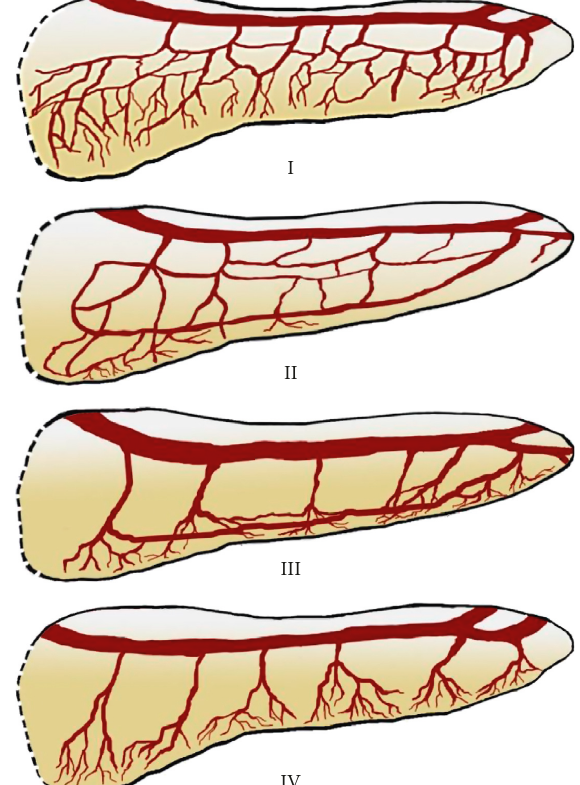
Figure 2: Schematic representation of the arterial supply of the pancreas by Roman Ramos and coworkers [10]. I: small arcades (type I), II: small and large arcades (type II), III: large arcades (type III), and IV: straight branches (type IV).